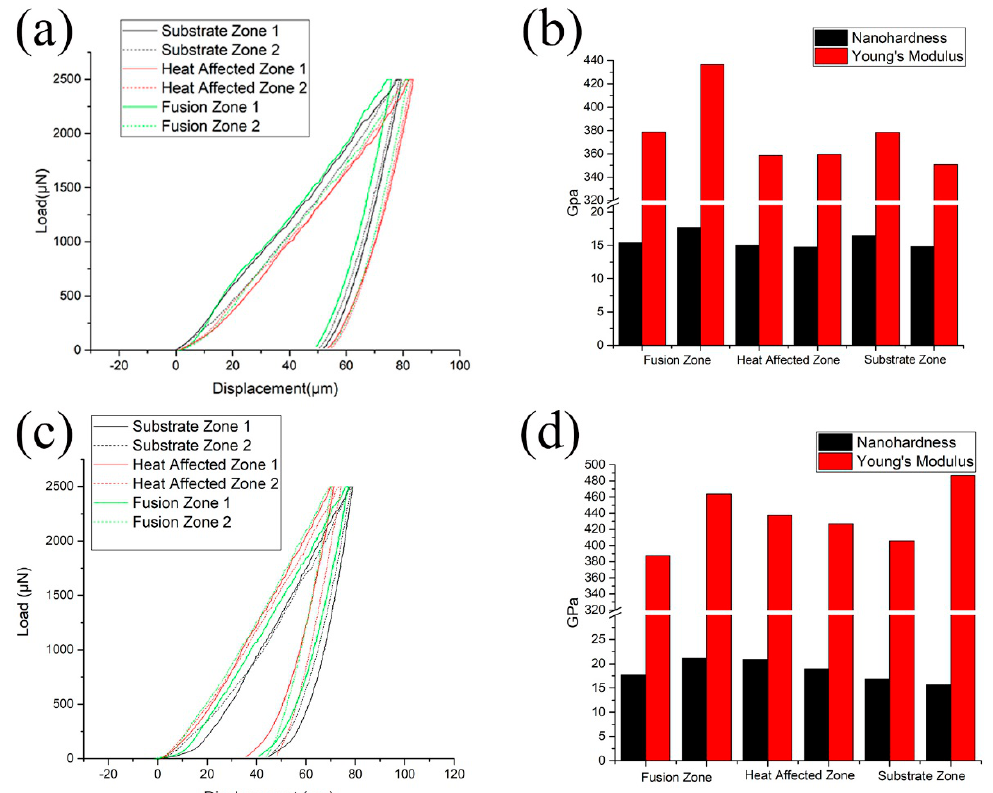
Figure 4. Nanoindentation curves of ( a ) the laser re-melted and ( c ) plasma arc re-melted DD407 superalloy samples within the fusion zone, heat-affected zone, and substrate zone, respectively. Their corresponding nanohardness and Young’s modulus of ( b ) the laser re-melted and ( d ) plasma arc re-melted DD407 superalloy samples.